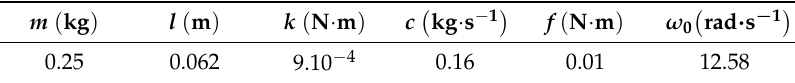
Table 1. Design parameters of the periodic coupled pendulums